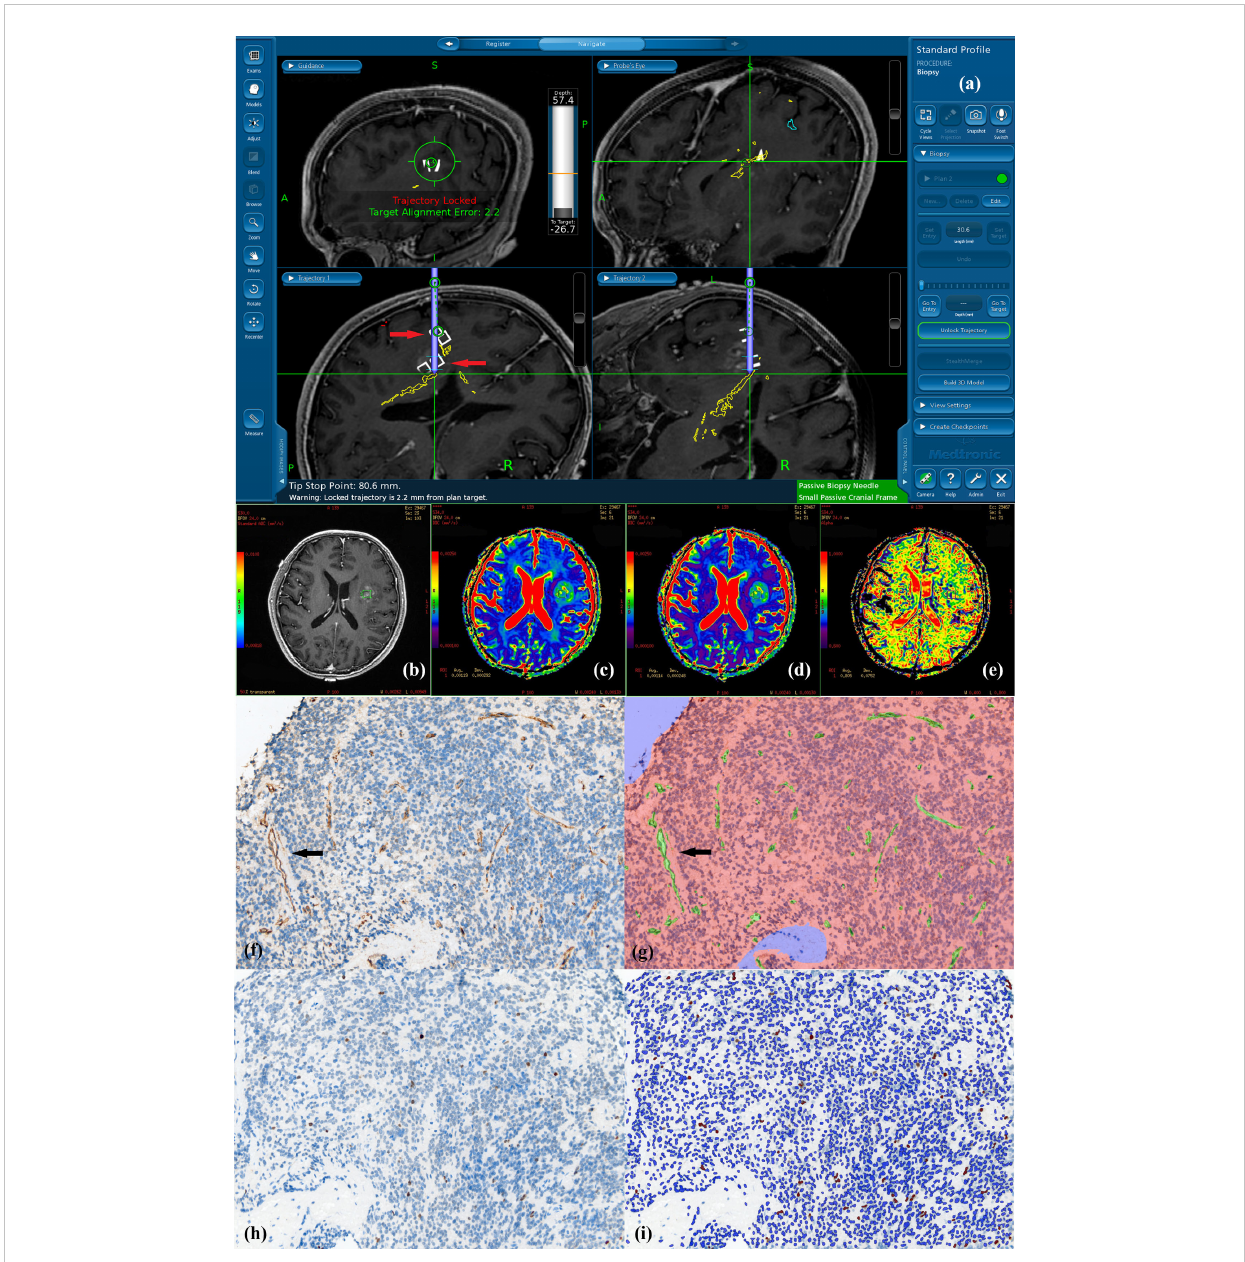
FIGURE 2 Navigated biopsy in a 57-year-old man with pathologically con fi rmed WHO grade III astrocytoma. (A) Preoperative enhanced T1WI imaging was used for MR-guided biopsy; two specimens were obtained within the marked target regions (two white square pointed by red arrow on the biopsy pathway) from the solid partition of tumor. (B) One deeper target ROI taking the biopsy target coordinate as the center is shown on axial T1C imaging within the contrast-enhance tumor (green square in B). (C) DDC 1500 mapping with the biopsy target (ROI: green square) (D) DDC 5000 mapping with the biopsy target (ROI: green square) (E) a 1500 mapping with the biopsy target (ROI: green square). (F) AntiCD34 immunohistochemical staining (original magni fi cation ×200 for all stains). (G) Computer assisted quanti fi cation is used to outline and calculate the neovascularization area in green. Arrows show microvasculature stained with CD34. (H) MIB-1 expression by using a high-power objective with a magni fi cation of 200×. Immunohistochemical dying of specimen from the biopsy target showed MIB-1 expression, proliferation indexes were 2.22%. (I) Computer assisted quanti fi cation is used to outline and calculate the MIB-1 expression area in